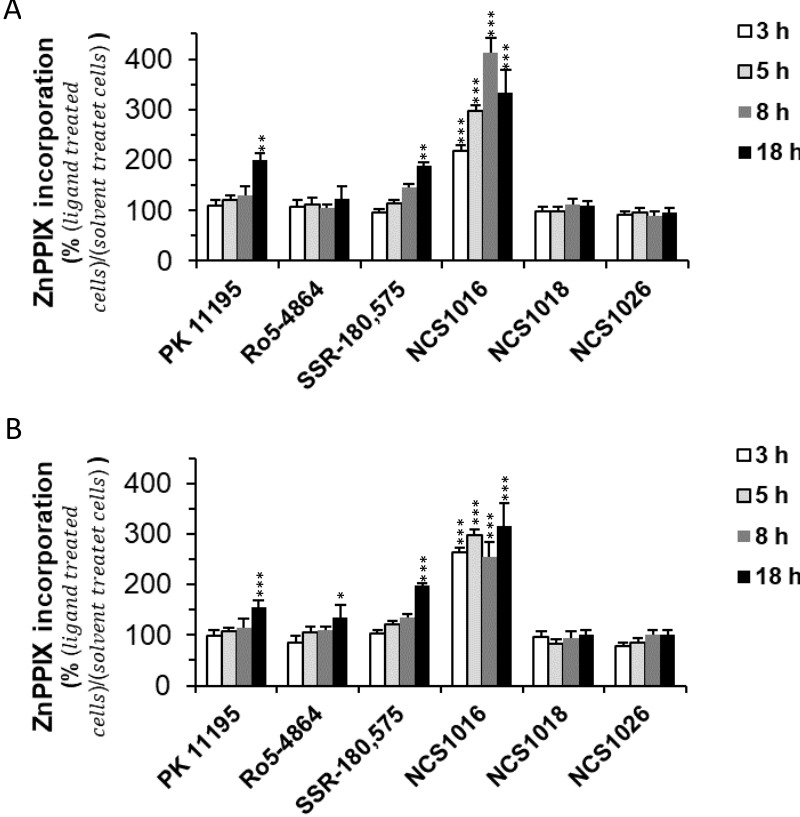
Figure 2. ZnPPIX uptake in healthy and infected RBCs induced by TSPO ligands. Healthy RBC ( A ) and infected RBC ( B ) at 2 to 5% parasitemia were incubated in the presence of 20 µM ZnPPIX and 50 µM TSPO ligands, and the uptake of ZnPPIX was assessed at different time points by flow cytometry. MFI values were normalized to background levels for the control and the ligand-treated conditions. Data are presented as the mean ± SEM; N = 7. Statistical analyses were performed for each ligand and the control condition. Differences were considered significant when * p < 0.05; ** p < 0.01; *** p < 0.001.